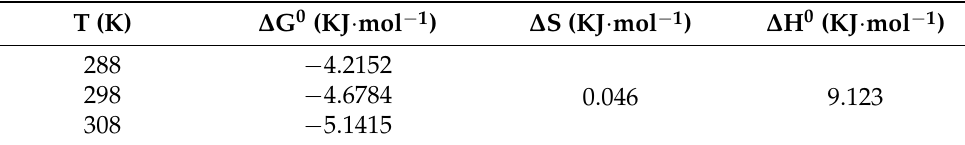
Table 4. Thermodynamic parameters at various